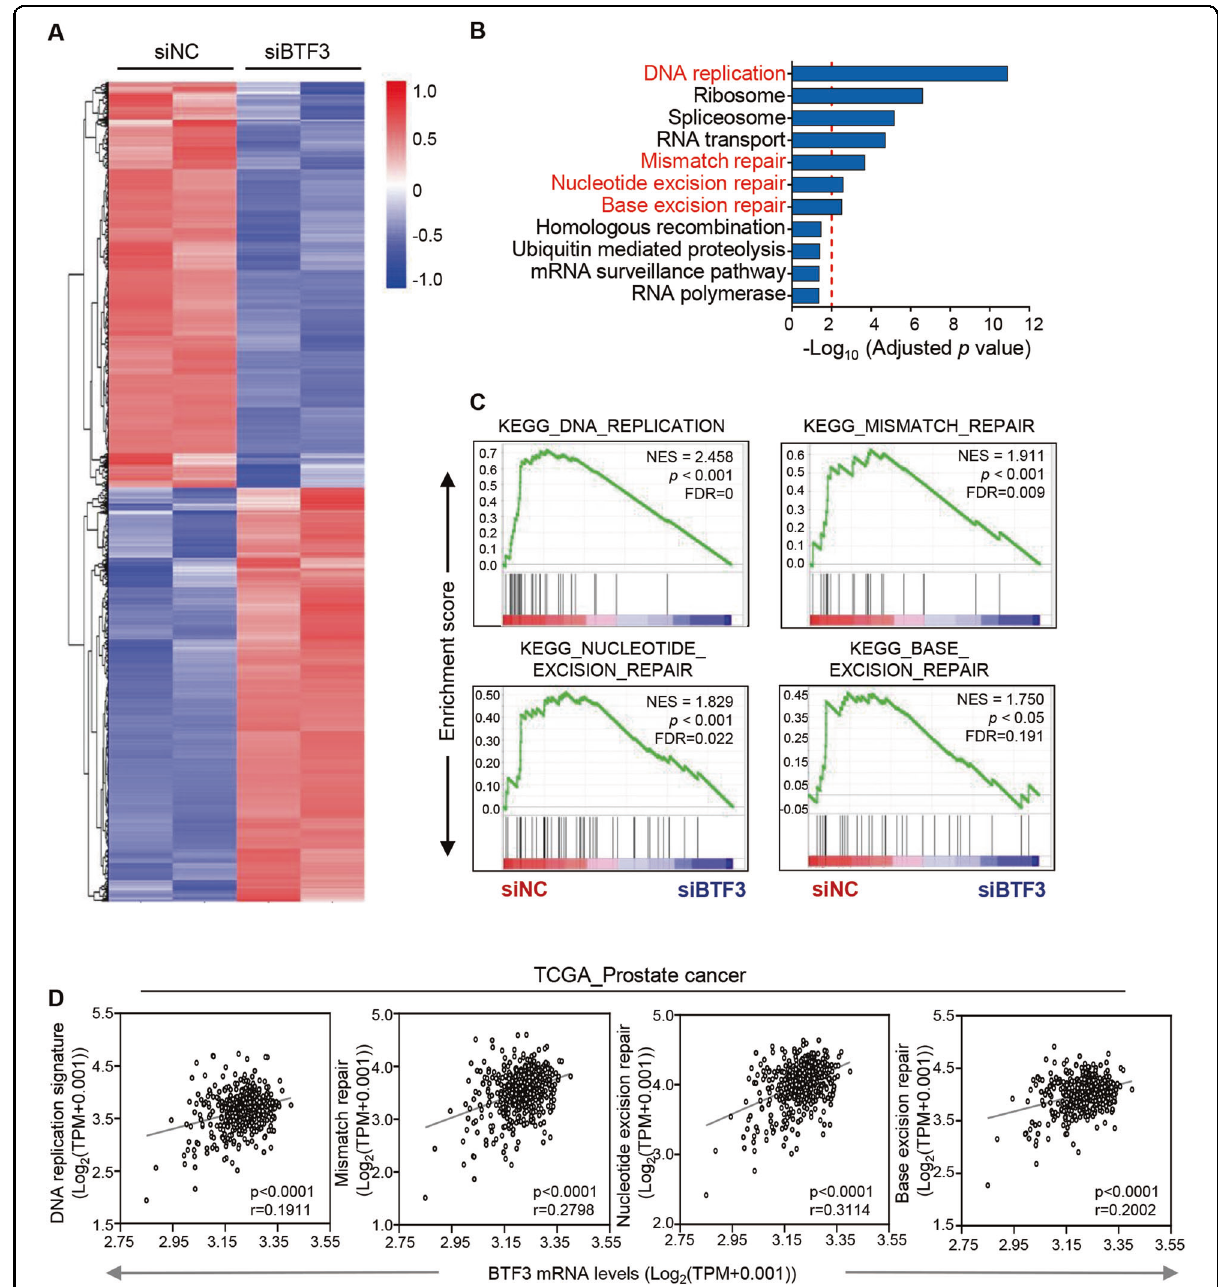
Fig. 2 BTF3 expression associates with DNA replication and DNA damage repair processes in prostate cancer cells. a Heat map expression plot of up-regulated and down-regulated genes in siBTF3 #1 transfected PC-3 cells versus control cells (siNC) as revealed by RNA sequencing. The gene expression was calculated according to the FPKM value. Genes with adjusted p -values less than 0.05 are shown. b KEGG pathway enrichment analysis of down-regulated gene sets upon BTF3 knockdown in PC-3 cells. Pathways with adjusted p -value less than 0.05 are shown. The threshold of adjusted p -value = 0.01 is shown as red dotted line. c GSEA analysis of the DNA damage repair gene signatures as indicated in siBTF3 transfected PC- 3 cells versus control cells. Normalized enrichment score (NES), p -value and False Discovery Rate (FDR) q value of the correlation are shown. d BTF3 gene expression was plotted against the DNA replication and DNA damage repair signatures as indicated for TCGA prostate cancer datasets ( n = 496). Gene expression levels are reported as log 2 (TPM + 0.001). Each dot represents an individual sample of human prostate tumors. The linear regression Spearman ’ s correlation coef fi cient (r) and its p -values are